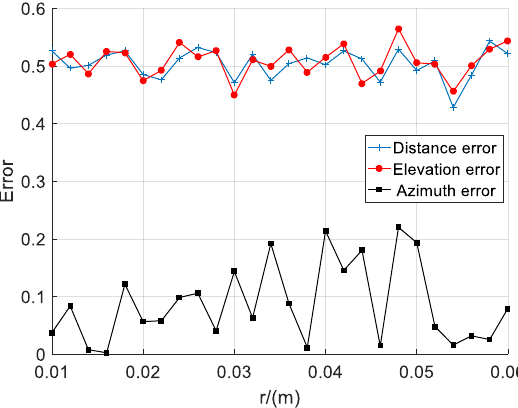
Figure 4. Relationship between sensor radius and localization error.